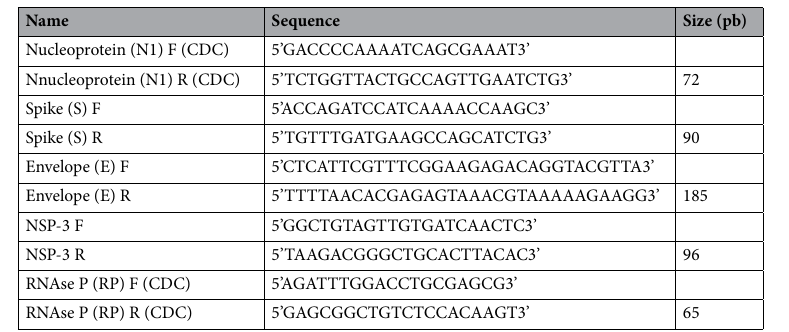
Table 2. PCR fragments to monitor